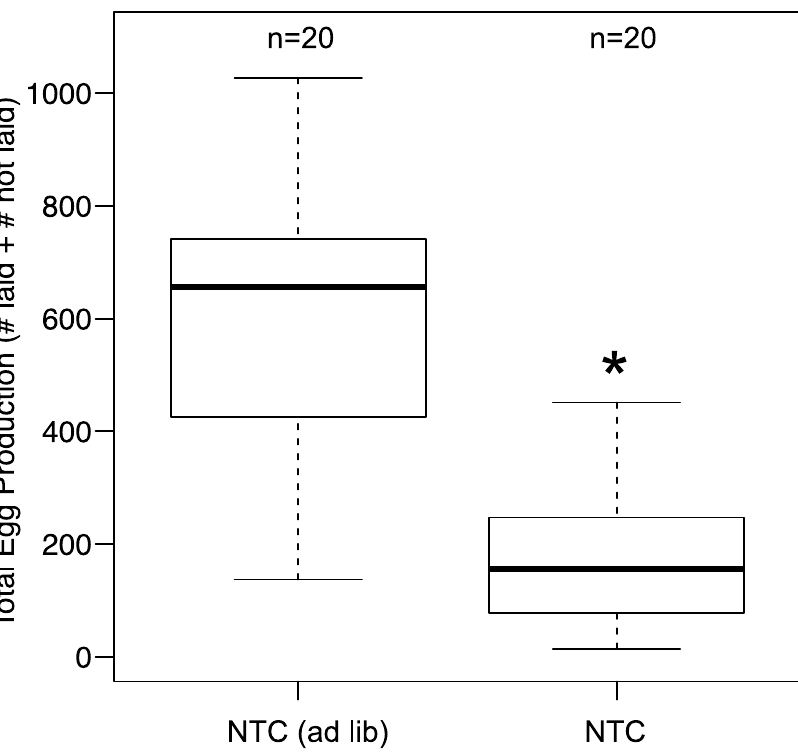
Fig 2. Effect of feeding condition on reproductive output. NTC crickets (food limited) produced fewer eggs (laid + not laid) by day 36 compared with NTC ( ad lib ). The bars represent the 25 th and 75 th percentile, the central line in bold represents the median and the error bars denote the maximum and minimum values for each group. Statistical information is described in the Results section.